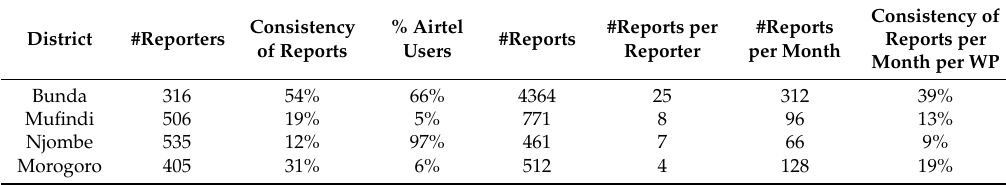
Table 4. Percentage of consistency of reporters per